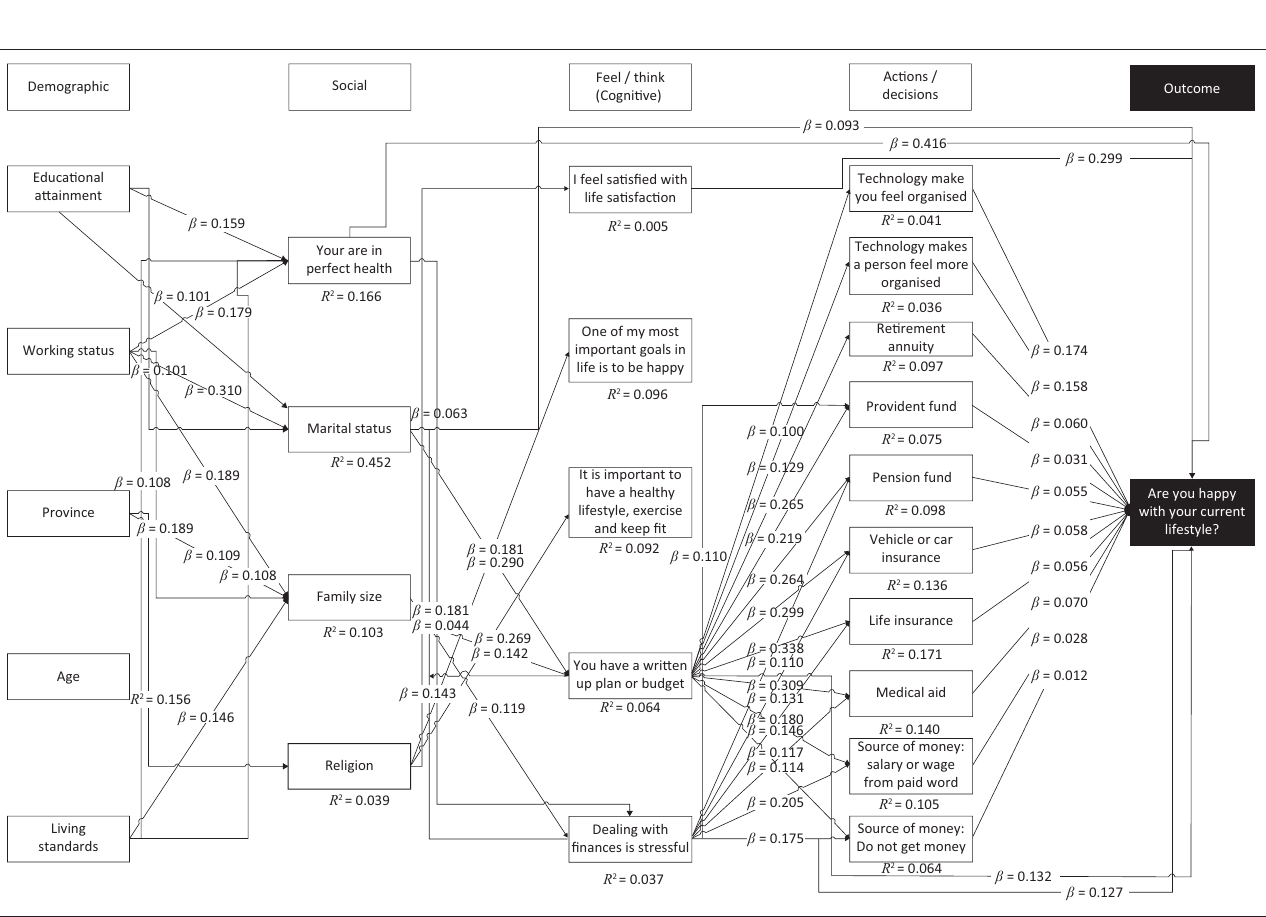
FIGURE 8: Intrinsic relationship among the various layers of variables with